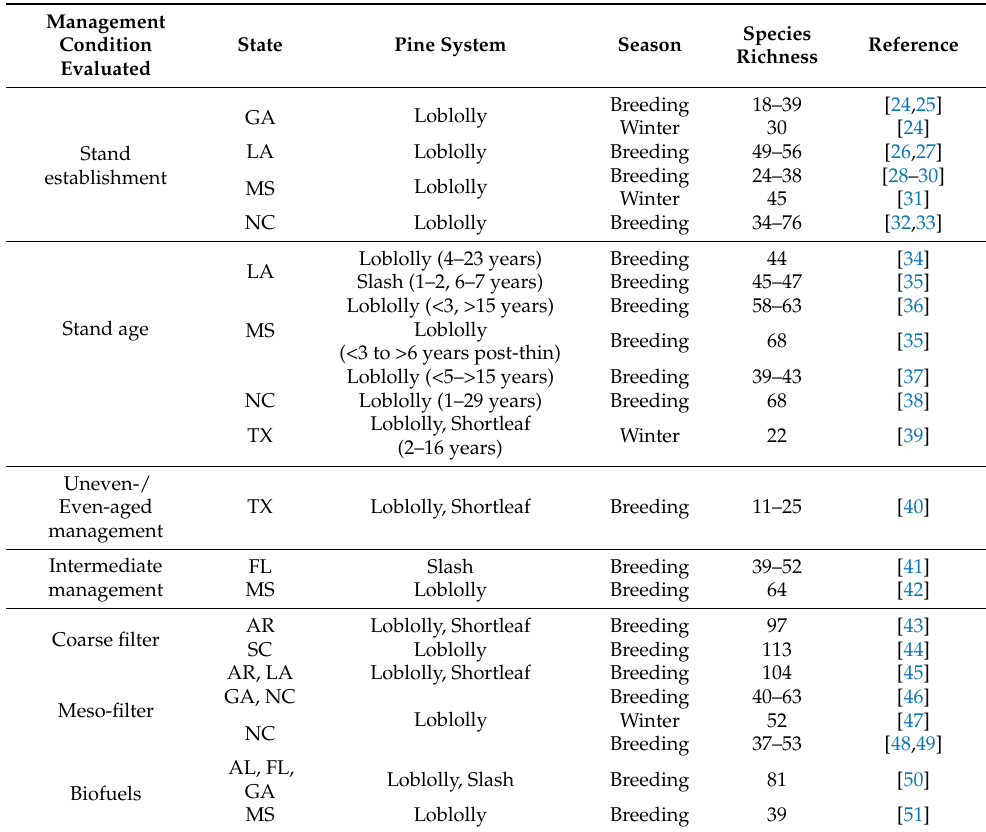
Figure 3. Box and whisker plot of avian species richness during breeding season and winter in managed pine systems across 29 publications in nine southeastern states (1996–2021). The center line represents median species richness, gray box represents interquartile range, whiskers represent range, and points represent outliers in the datasets. Table 2. Summary of avian species richness quantified by studies conducted on southeastern managed pine landscapes subjected to a variety of conventional management practices during since the beginning of SFI and FSC forestry standards (1996–2021).